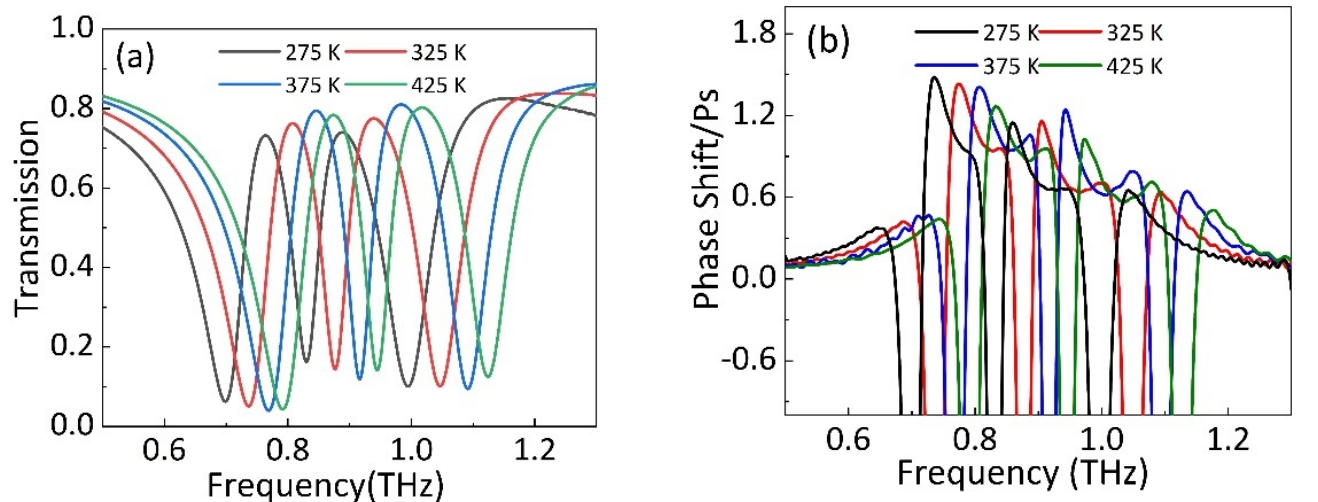
Figure 9. In the absence of graphene strips, ( a ) the transmission and ( b ) group delay of PIT metamaterial with different temperature of STO film.